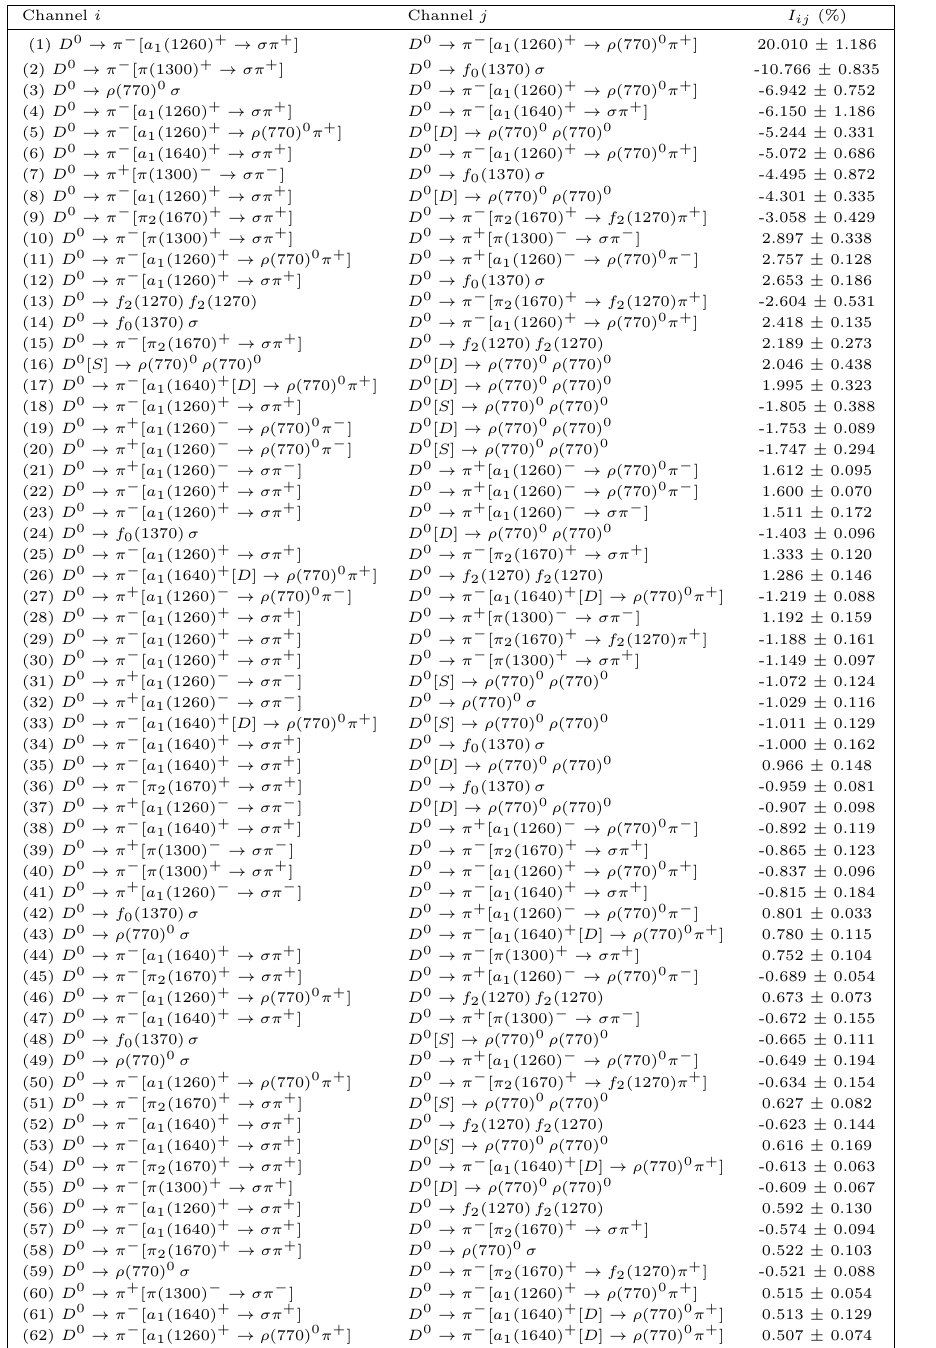
Table 21 . Interference fractions j I ij j > 0 : 5%, as de(cid:12)ned in eq. (4.27), ordered by magnitude, for the nominal D ! (cid:25) + (cid:25) (cid:0) (cid:25) + (cid:25) (cid:0) amplitude (cid:12)t. Only the statistical uncertainties are given.